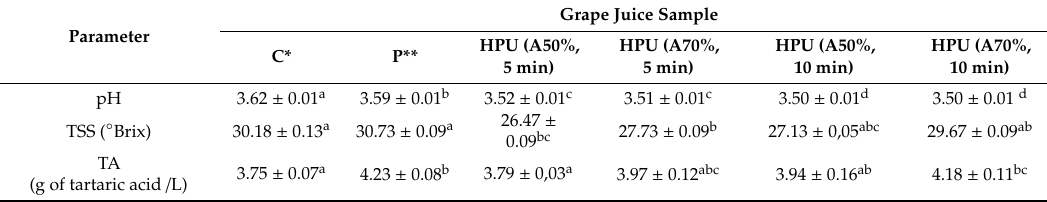
Table 4. E ff ects of ultrasound and pasteurization treatments on the pH, total soluble solids (TSS) and titratable acidity